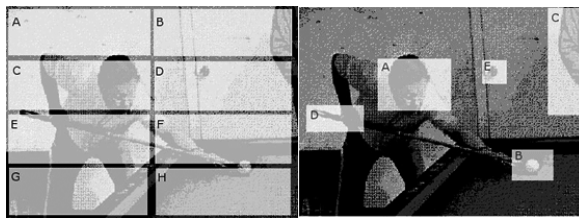
Figure 3. For comparison of scanpaths the presented picture is divided into ROIs. A unique label is attached to a region (e.g., letters). In that way the two-dimensional fixation-saccade se- quence is reduced to a one-dimensional sequence of letters. For definition of ROI´s two regionalization were used: geometrical (left) or “a priori”, and “a posteriori” or intelligent